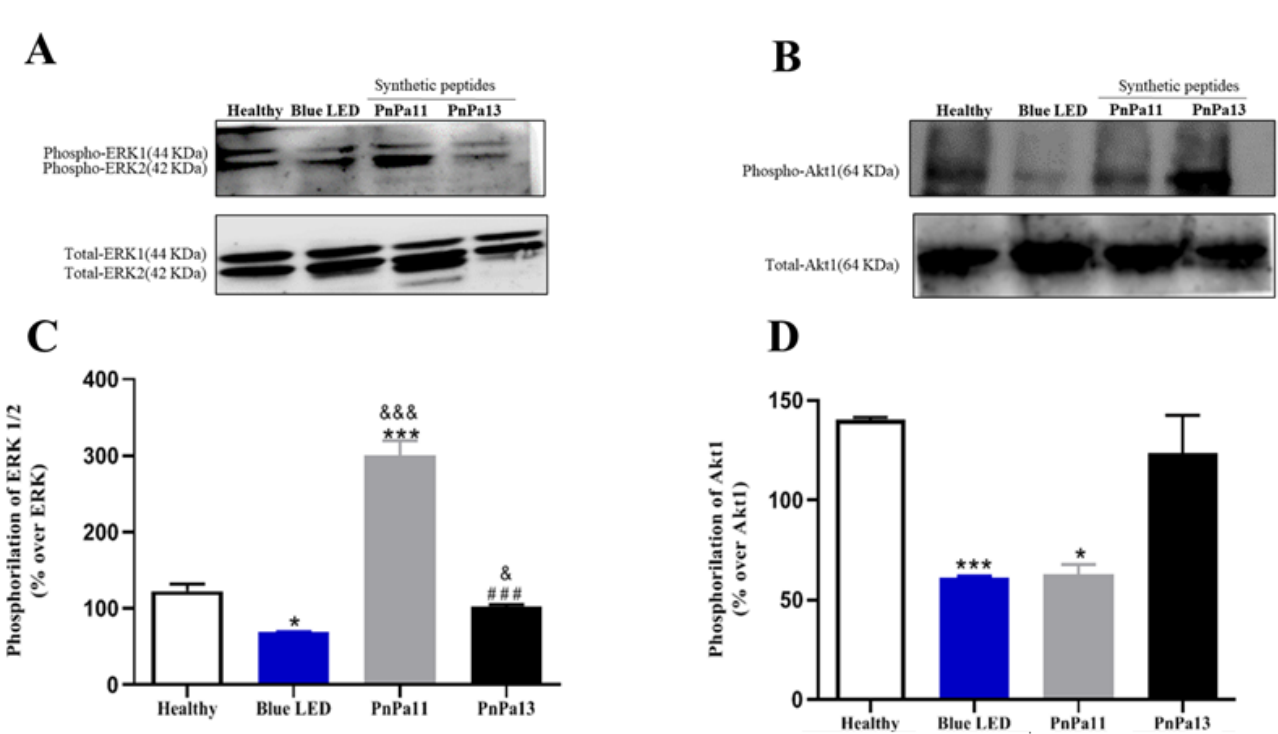
Figure 8. PnPa11 increases Erk1/2, but not Akt1 activation, while PnPa13 does not modulate Erk1/2 and Akt1 phosphorylation against Blue LED damage. Shown are representative immunoblots for (A) phospho-(upper panel) and total-Erk1/2, (B) phospho-(upper panel) and total-Akt1expression (lower panel) in retina of healthy rats, rats that were blue LED exposed (vehicle-treated), treated with PnPa11 (1.25 µg/mL), or PnPa13 (1.25 µg/m) before blue LED light exposure. About 100 mg of cell lysate was used for each sample. Graphs show the densitometric analysis of (C) phospho-Erk1/2 or (D) phospho-Akt1 normalized to total-Erk1/2 or total-AKT expression in retina of healthy rats and rats that were blue LED-exposed (vehicle-treated), treated with PnPa11 (1.25 µg/mL) or PnPa13 (1.25 µg/mL) before LED light exposure. Data represent the means ± SD of four independent experiments (healthy and PnPa11) and three independent experiments (blue LED and PnPa13), expressed as percentage of basal Erk1/2 or Akt1 phosphorylation. *Significant differences as compared with healthy (*p < 0.05). & Significant differences as compared with blue LED ( & p < 0.05). # Significant differences as compared PnPa11 with PnPa13 ( # p < 0.05). Analysis was carried out using two-way ANOVA followed by Bonferroni